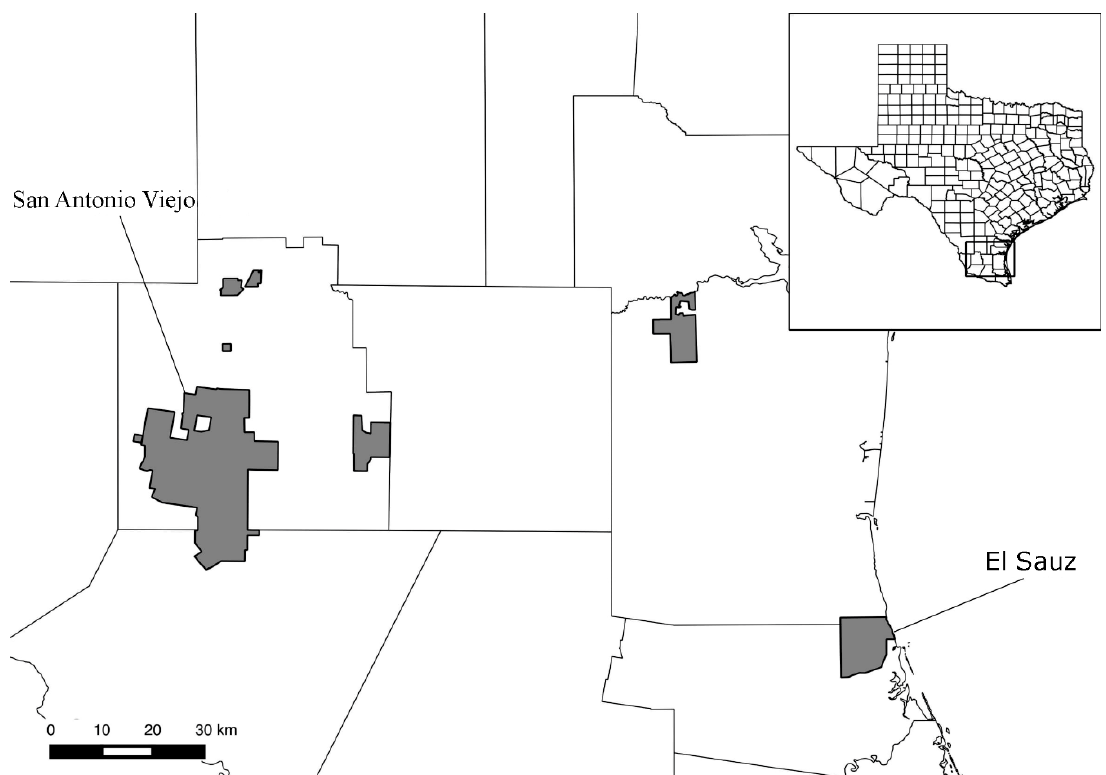
Figure 1. Map of Texas, with an emphasis on south Texas and all East Foundation properties (shaded regions). The two properties for this study (San Antonio Viejo and El Sauz) are indicated.